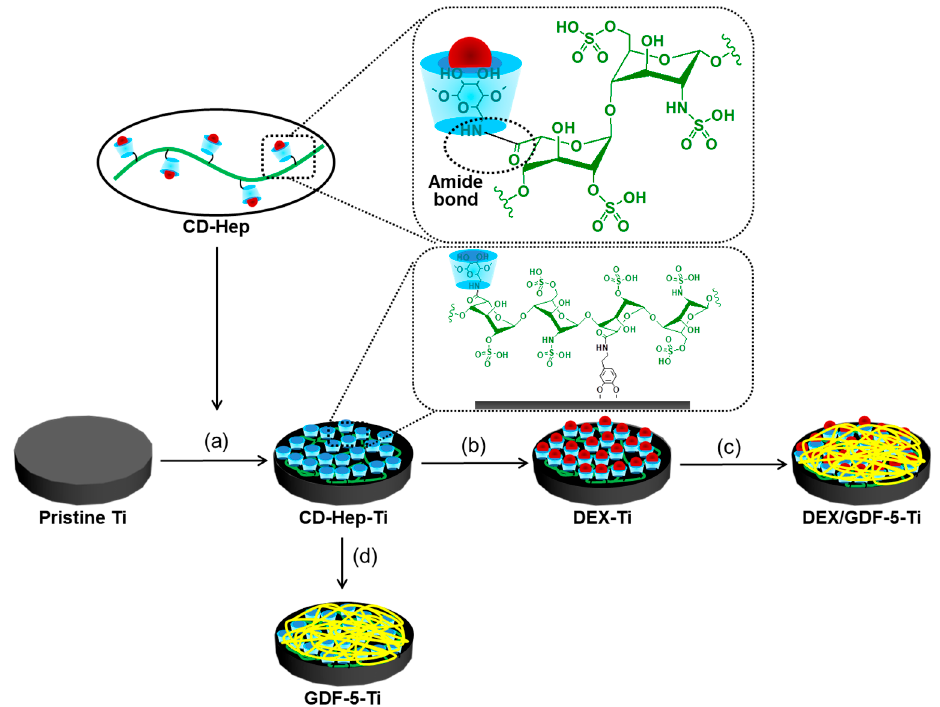
Figure 9. Schematic illustration on the surface modification of titanium discs (diameter: 8 mm; height: 1 mm) and screws ( φ 3.5 × 8.5 mm) using DEX and/or GDF-5 by β -CD and heparin. The two types were surface-modified by same process.